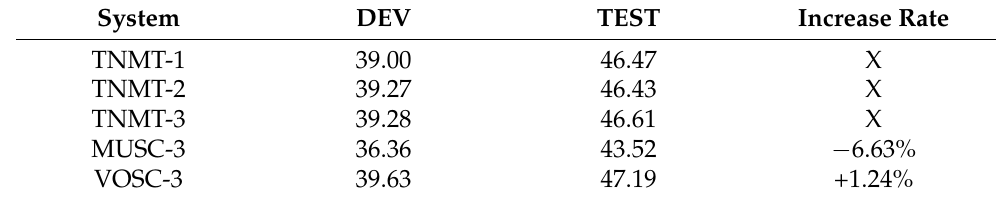
Table 7. Results on homogeneous systems with similar performance for Uyghur–Chinese translation.